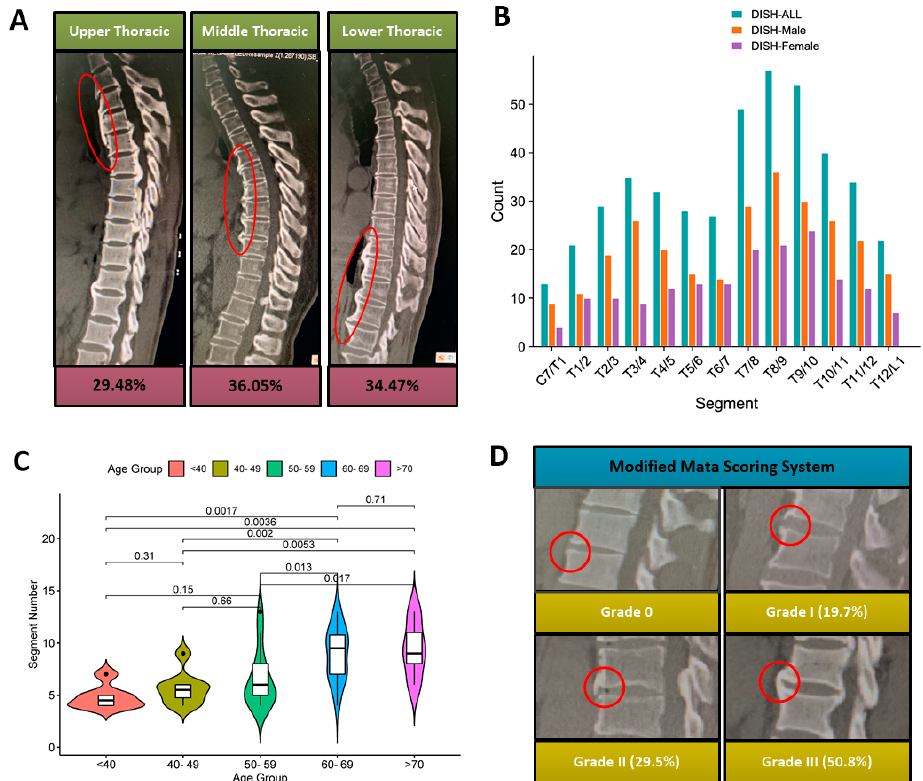
Figure 2. Distribution characteristics of DISH in TOLF patients. ( A ) Regional distribution. Ossification involving the upper, middle, and lower thoracic spine accounted for 29.48%, 36.05%, and 34.47%, respectively. ( B ) Segmental distribution. T 8,9 (94.8%) and T 9,10 (91.4%) were the segments where DISH occurs mostly. ( C ) The average numbers of ossified lesions might increase with age. ( D ) Severity distribution based on the Meta scoring, the proportion of I, II and III grade were 19.7%, 29.5% and 50.8%, respectively.